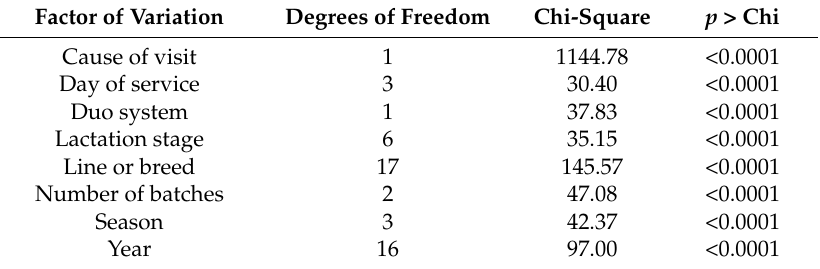
Table 3. Factors of variation for prevalence of clinical mastitis of rabbit does, and test of significance of the effects. Physical examination of 144,455 does on 490 rabbit farms in Spain and 41 farms in Portugal, from 2001 to